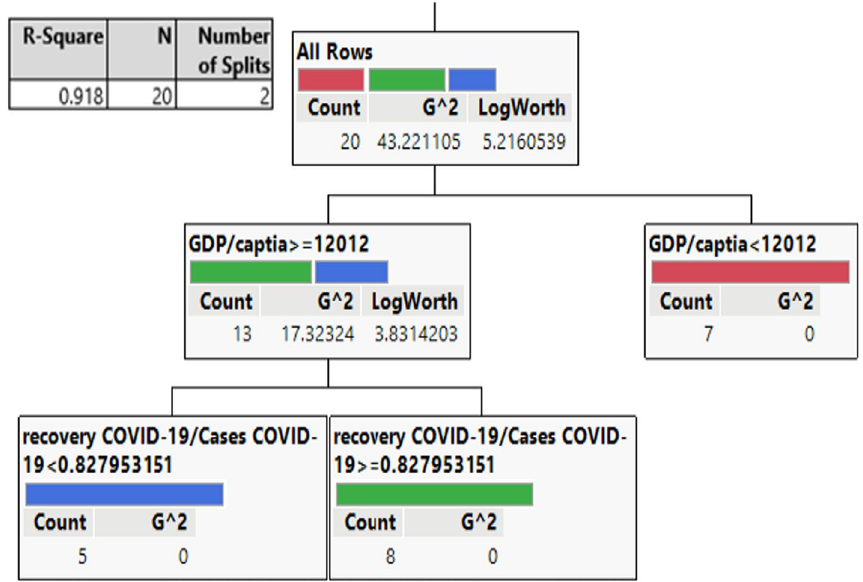
Fig. 5 Classification regression